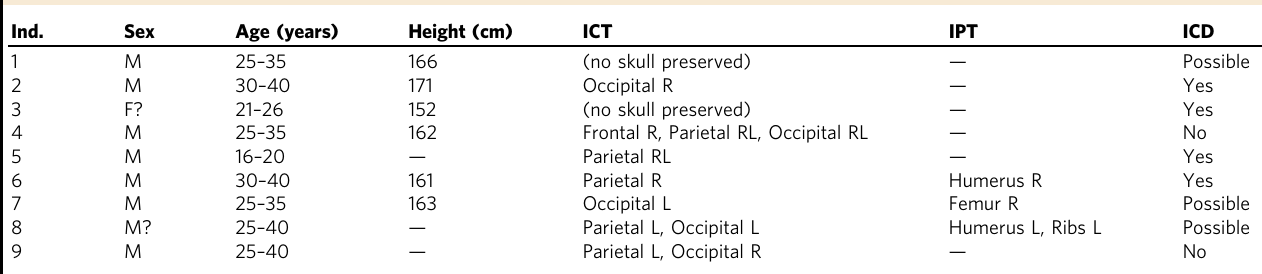
Table 1 Osteological characteristics of the individuals found in the mass grave